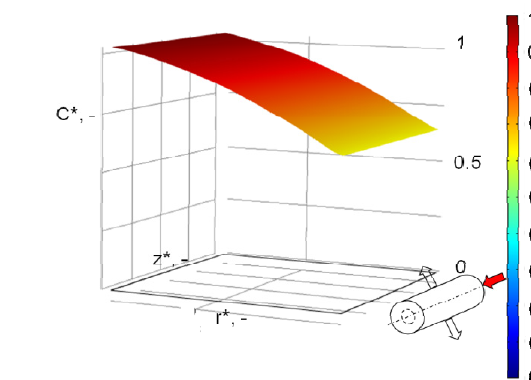
= 3910); ( b ) radially outwards (Pe ax = 10 7 cell/mL, G = 5.5 × 10 − 17 mol/(s · cell), L = 40 cm. Other C